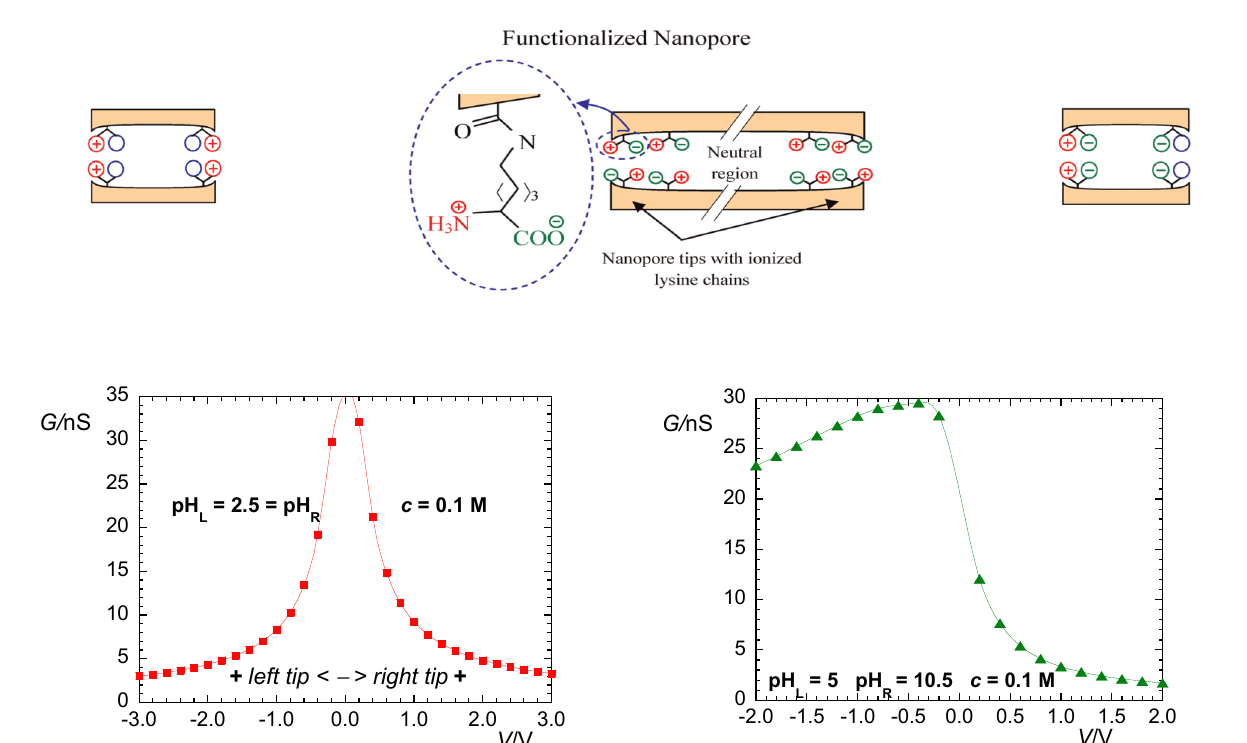
Figure 2. Sketch of the nanopore (not to scale) functionalized with amino acid lysine ( top ). Due to the geometry of the pore, the carboxylic acid and amino groups are concentrated close to the pore tips. Note that these pH-dependent charge groups are also present in connexin proteins. Conductance vs. voltage curves at 0.1 M KCl concentration with pH L = pH R = 2.5 ( bottom , left ) and pH L = 5 and pH R = 10.5 ( bottom , right ). The cartoons above each curve illustrate the distribution of fixed charges at the pore mouths ( top ). Experimental data taken from [43]: M. Ali, P. Ramirez, H Q. Nguyen, S. Nasir, J. Cervera, S. Mafe, W. Ensinger. Single cigar-shaped nanopores functionalized with amphoteric amino acid chains: experimental and theoretical characterization. ACS Nano 2012 , 6 , 3631–3640. Copyright 2012 American Chemical Society.